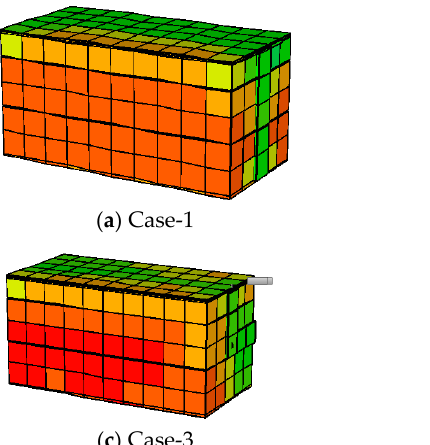
( d ) Water Figure 29. Oil recovery comparison between different directions of scattered fracture.